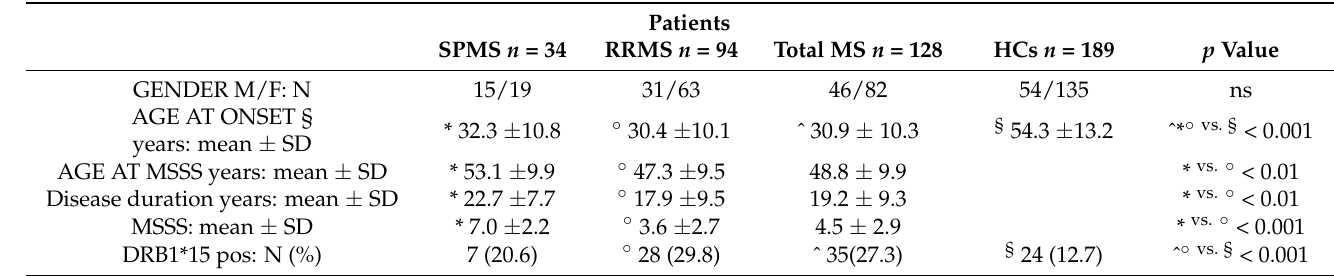
Table 1. Demographic and clinical data of MS patients with secondary chronic progressive disease course (SPMS), patients with relapsing–remitting MS (RRMS), and healthy controls (HCs).